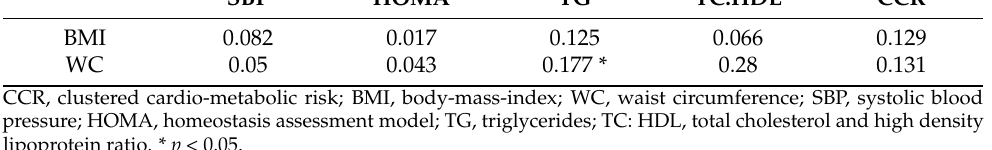
Table 3. Caucasian partial correlations (adjusted for Gender, Age, Maturation, and Physical Activity levels) for individual CVD risk factors and clustered cardio-metabolic risk with BMI and WC. SBP HOMA TG